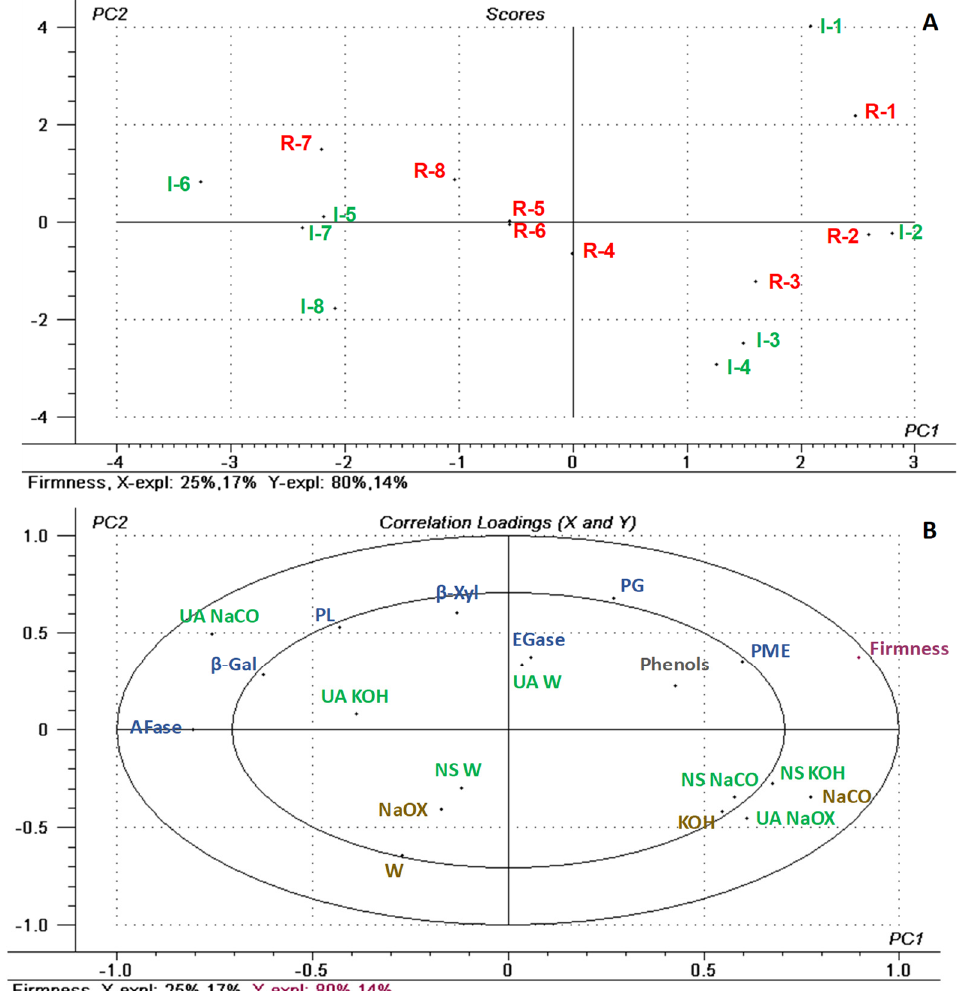
Figure 4. ( A ) Scores plot of PC1 vs. PC2 corresponding to a Partial Least Squares Regression (PLSR) model for ‘Arbequina’ fruit firmness ( Y variable) vs. a set of potentially explanatory X variables. Codes 1 to 8 denote successive picking dates throughout on-tree fruit maturation under irrigated ( I ) and rainfed ( R ) conditions. ( B ) Correlation loadings plot of PC1 vs. PC2 for the same model (Abbreviations: W, water-soluble fraction; NaOX, sodium oxalate-soluble fraction; NaCO, sodium carbonate-soluble fraction; KOH, potassium hydroxide-soluble fraction; UA, uronic acid content; NS, neutral sugar content; AFase, β -Gal, β -Xyl, EGase, PG, PL, PME, α -L-arabinofuranosidase, β -galactosidase, β -xylosidase, endo-1,4- β -D-glucanase, polygalacturonase, pectate lyase and pectin methylesterase activities, respectively.